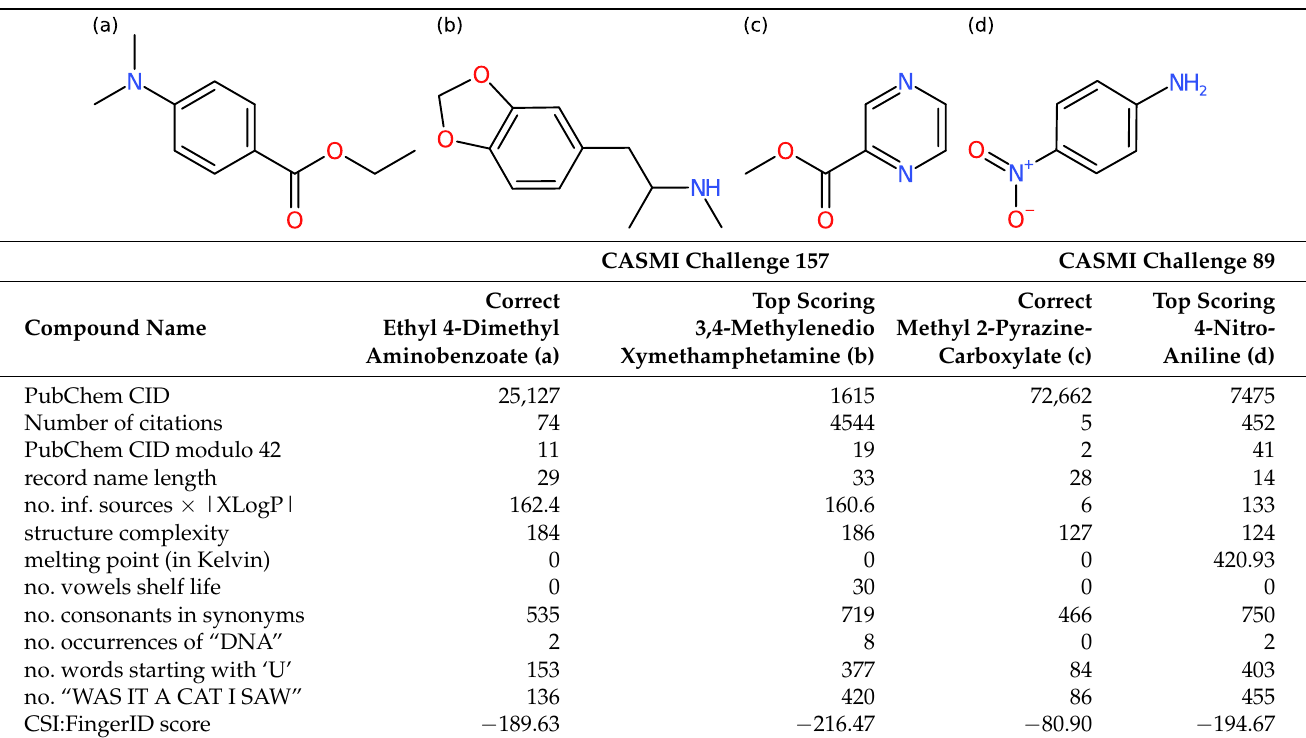
Table 2. Examples of overshadowing. Left: CASMI 2016 challenge 157. Here, two blockbusters (ethyl 4-dimethylaminobenzoate and 3,4-methylenedioxymethamphetamine) compete with each other, and the bigger blockbuster wins. Right: CASMI 2016 challenge 89. The correct CSI:FingerID